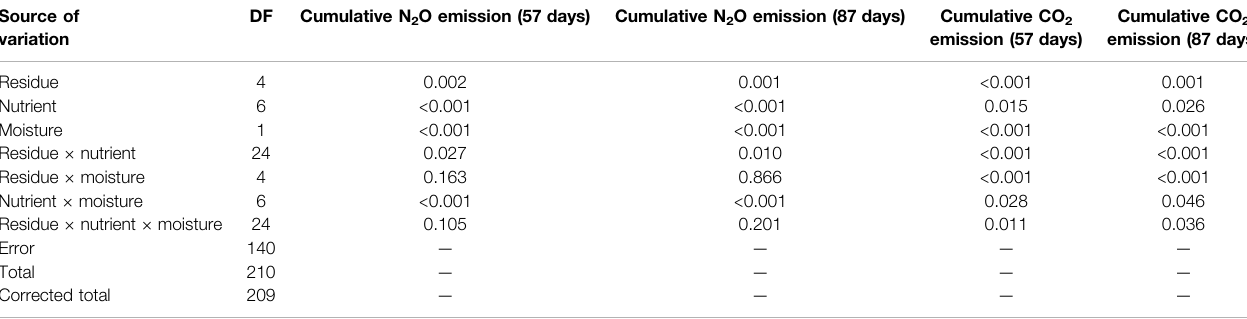
TABLE 4 | ANOVA for cumulative N 2 O emission and soil CO 2 respiration after 57 and 87 days of incubation. Source of variation